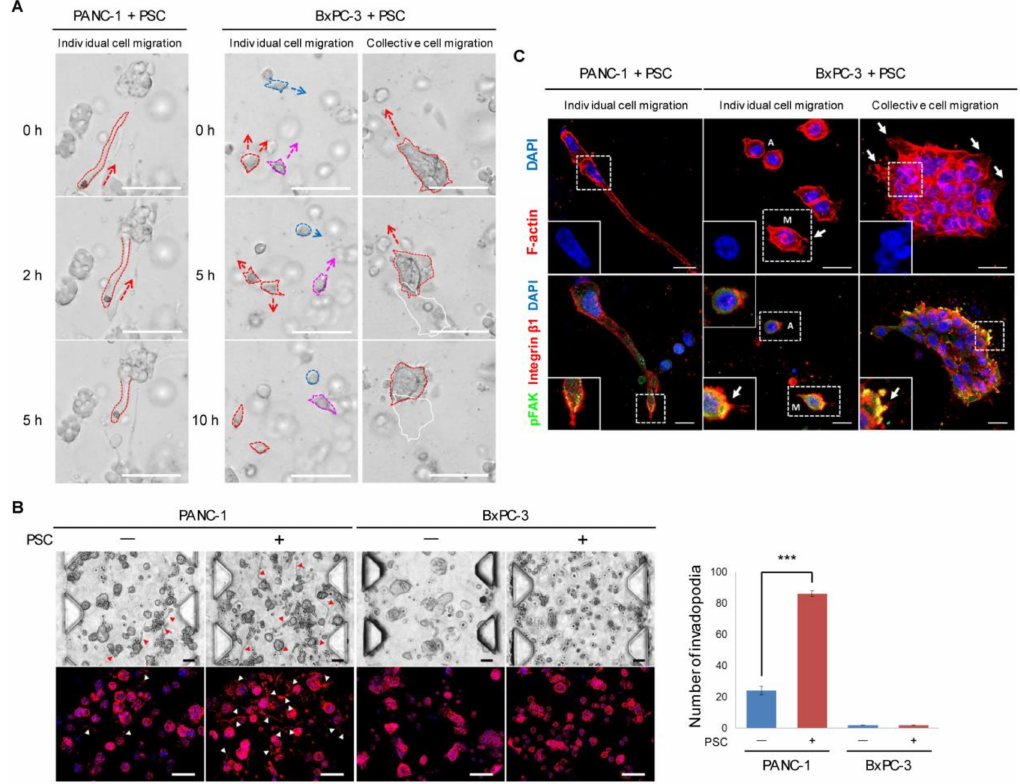
Figure 3. Di ff erence in migration mode and FAK activation between PANC-1 and BxPC-3 cells in a collagen matrix. ( A ) Time-lapse images of cell migration under PSC co-culture conditions, showing di ff erential migration modes. Direction of cell migration is indicated by arrows. Scale bar: 100 µ m. ( B ) Increased number of invadopodia (arrowhead) in PANC-1 TSs under PSC co-culture conditions. Scale bar: 100 µ m. ( C ) Comparison of podium morphology and expression of pFAK at the leading edge of the protrusion between PANC-1 and BxPC-3 cells under co-culture conditions. A: amoeboid mode. M: mesenchymal mode. White arrow: spike-like filopodia. Scale bar: 20 µ m. Three fields covering 80% of the e ff ective area in each channel were imaged per experiment and subjected to analysis. Data were obtained from three separate independent experiments. *** p <